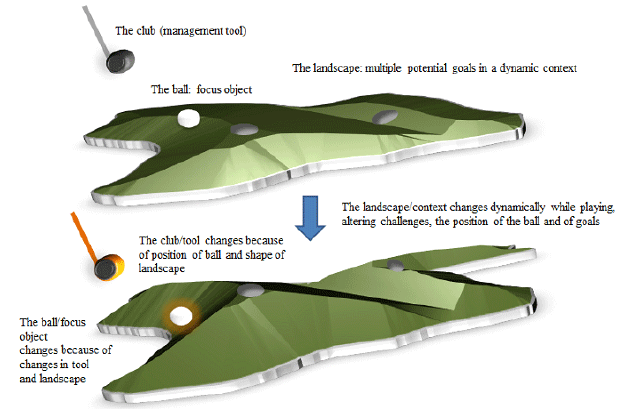
Fig. 4 . ChaosGolf. The player plays minigolf in a continually changing landscape, where slopes and targets shift. Playing in the landscape is a metaphor for adaptive management: not only the landscape (conditions) shifts, the ball (management object) and the club (management tool) can also change properties. All of these elements are additionally linked. The figure shows two snapshots of the landscape, club and ball